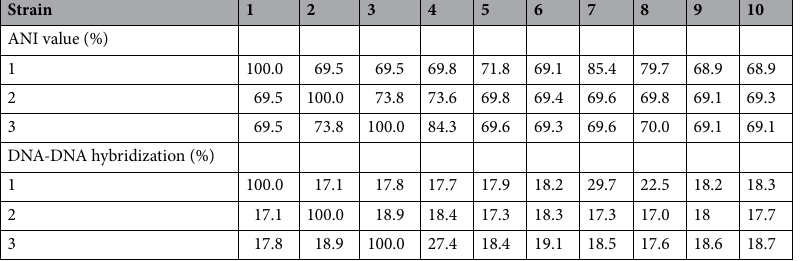
Table 5. ANI values calculated using EzBioCloud service and digital DNA-DNA hybridization values calculated on Genome-to-Genome Distance Calculator 3.0 among novel strains: 1, SS9-22 T (CP089981); 2, W9P-11 T (CP089979); 3, SW1-E11 T (CP089980), with the closest reference strains: 4, F. sediminis 2943 T (JAESIY000000000); 5, F. imtechensis JCM 17390 T (AMZN00000000); 6, F. aurantia KCTC 82638 T (SMMD00000000); 7, F. kasyanovii KCTC 12832 T (SMLW00000000); 8, F. marina 29W222 T